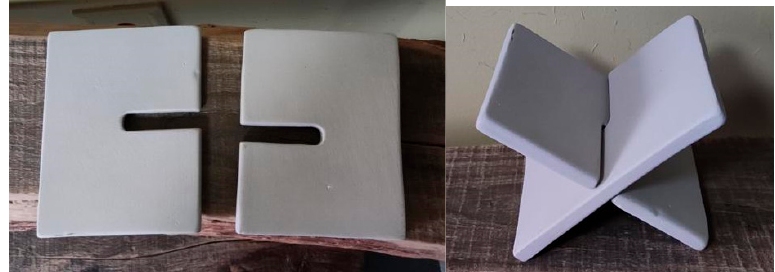
Figure 7. Prototype of ceramic rehal.